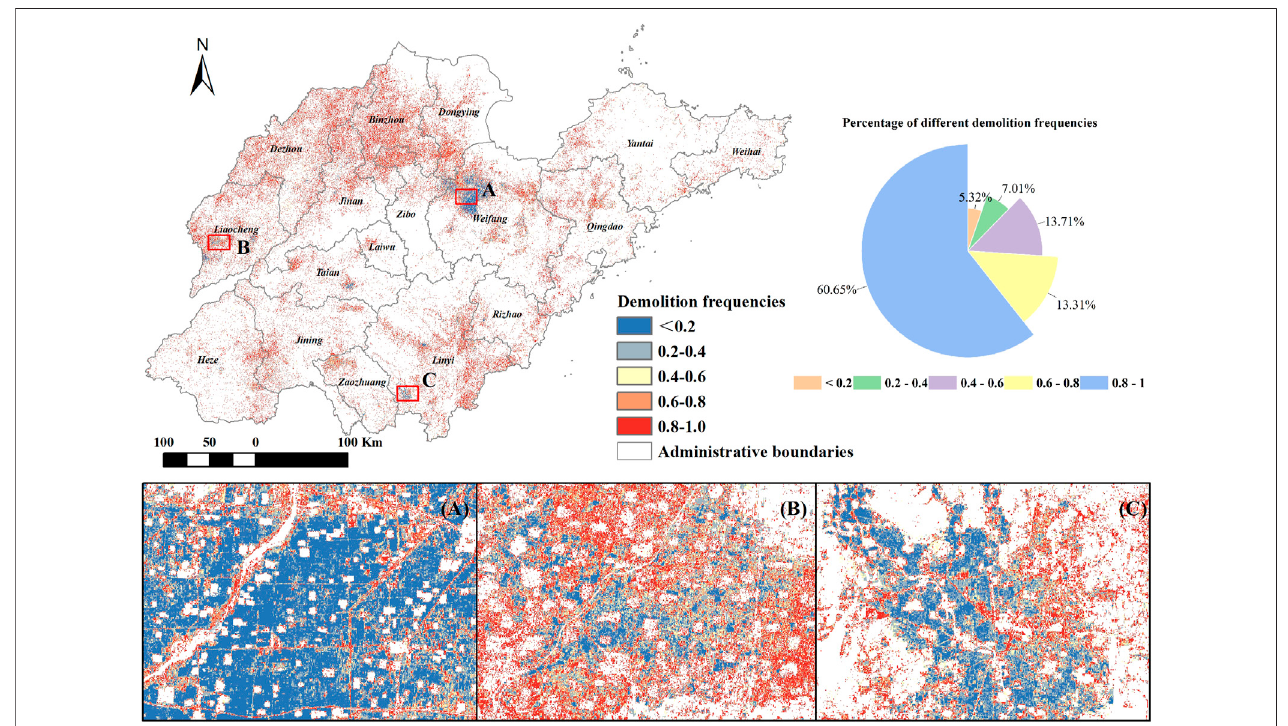
FIGURE 5 | The demolition frequency patterns of GCL: (A) enlarge area A, (B) enlarge area B, and (C) enlarge area C.